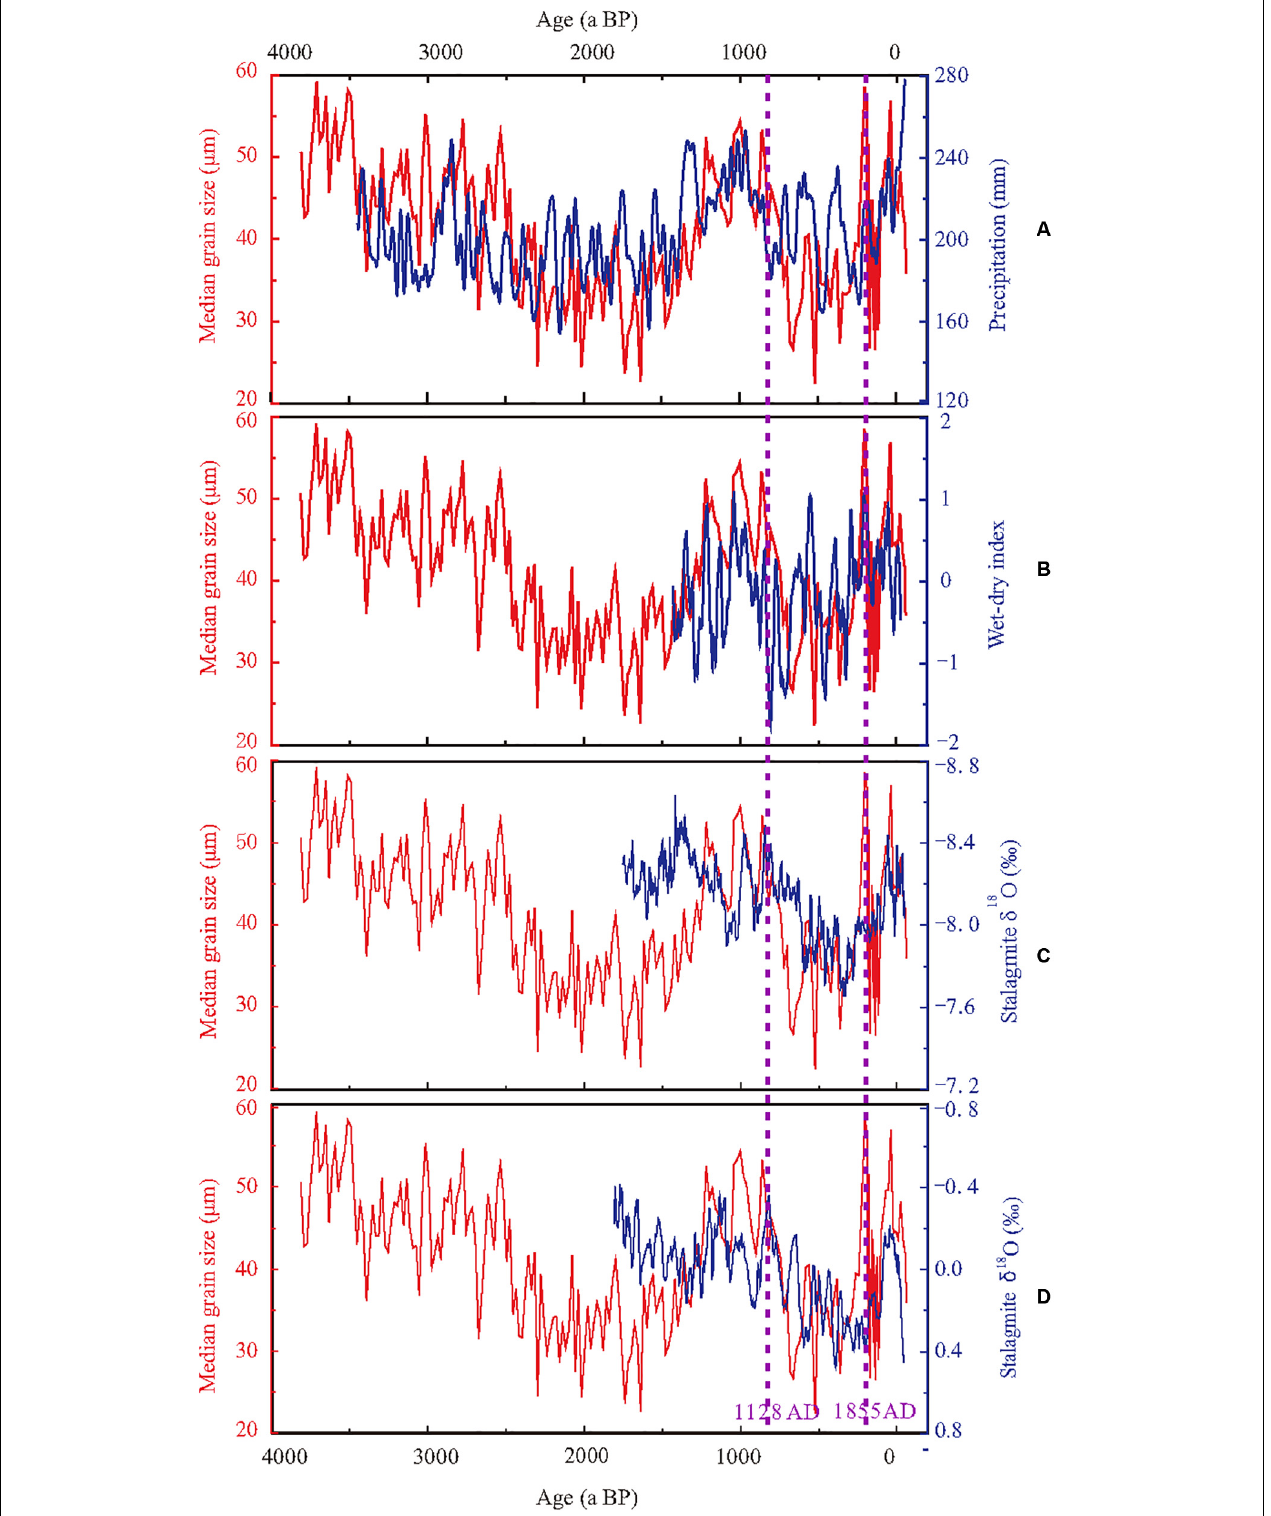
FIGURE 5 | Comparison of median grain size in sediments from Core 38002-A and other monsoon precipitation records. (A) Precipitation reconstructed by tree-ring analysis (Yang et al., 2014), (B) Wet-dry index of northern China (Zheng et al., 2006), (C) Stalagmites δ 18 O from Wanxiang cave (Zhang et al., 2008), (D) Stalagmites δ 18 O from Huangye cave (Tan et al.,